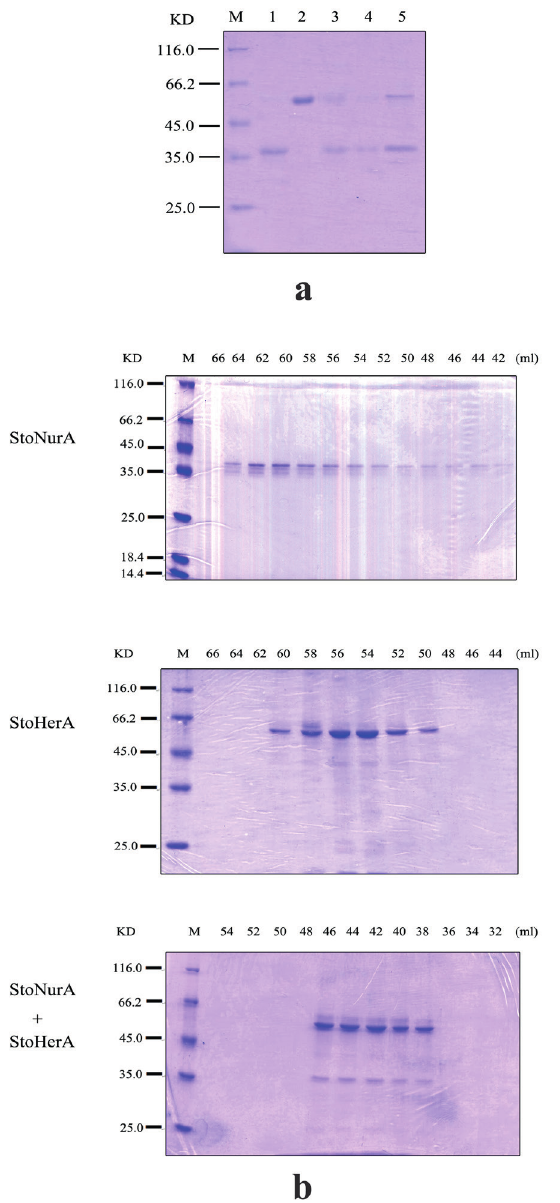
Figure 6 - ( a ) Physical interaction between StoNurA and StoHerA by pull-down assay. Lane 1, molecular size markers; Lane 2, purified His-tagged StoNurA;Lane 3, purified untagged StoHerA; Lane 4, flow-through of the mixture; Lane 5, wash with washing buffer; Lane 6, elution with buffer containing 500 mM imidazole. ( b ) Sephacryl S-200 gel filtration of purified StoHerA and StoNurA. Purified proteins were incubated alone (StoNurA: top panel, StoHerA: middle panel) or in combination (bottom panel) at 65 °C for 30 min before gel filtration, as indicated, and fractions were analyzed by 12% SDS-PAGE. Migration of protein markers are indicated. (see the colors in the online